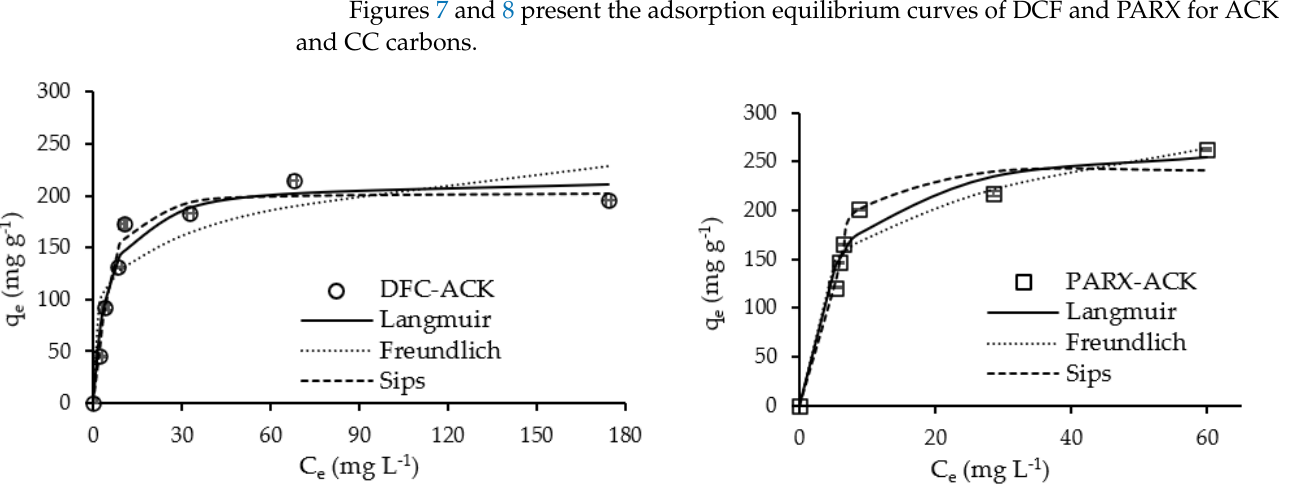
Table 6. Kinetic parameters obtained from the adjustment of the PFO and PSO models to the exper ‐ imental kinetic data.